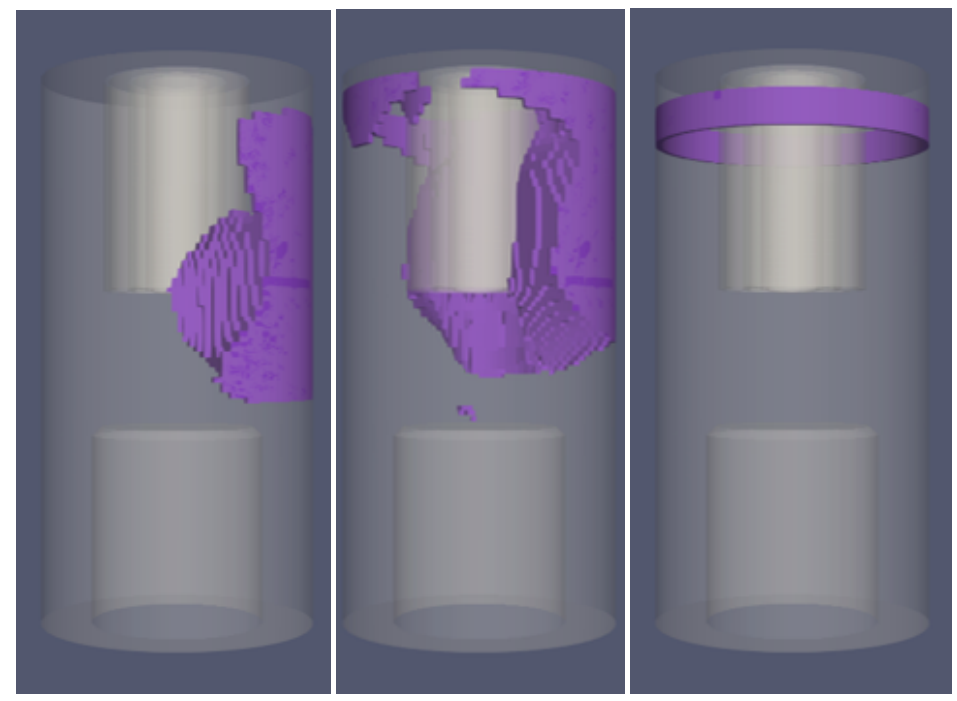
Figure 3. Vertical cut through the HVPE reactor that shows the distribution of Y NH reactor; ( b ) up-flow reactor.